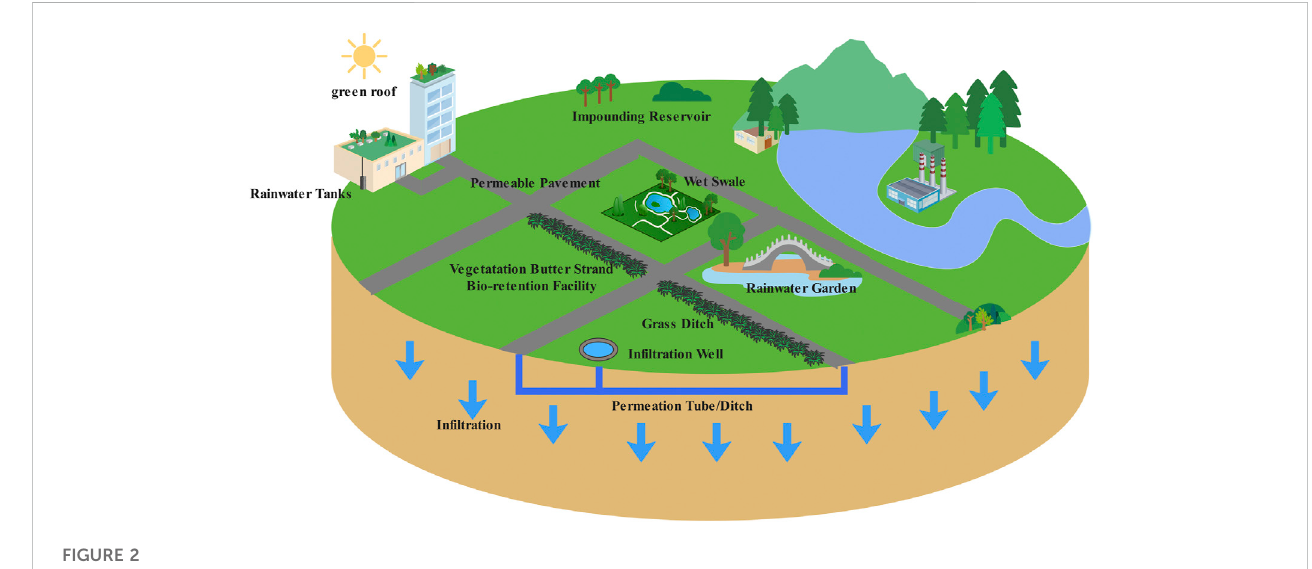
FIGURE 2 Distribution of rainwater measures in cities.